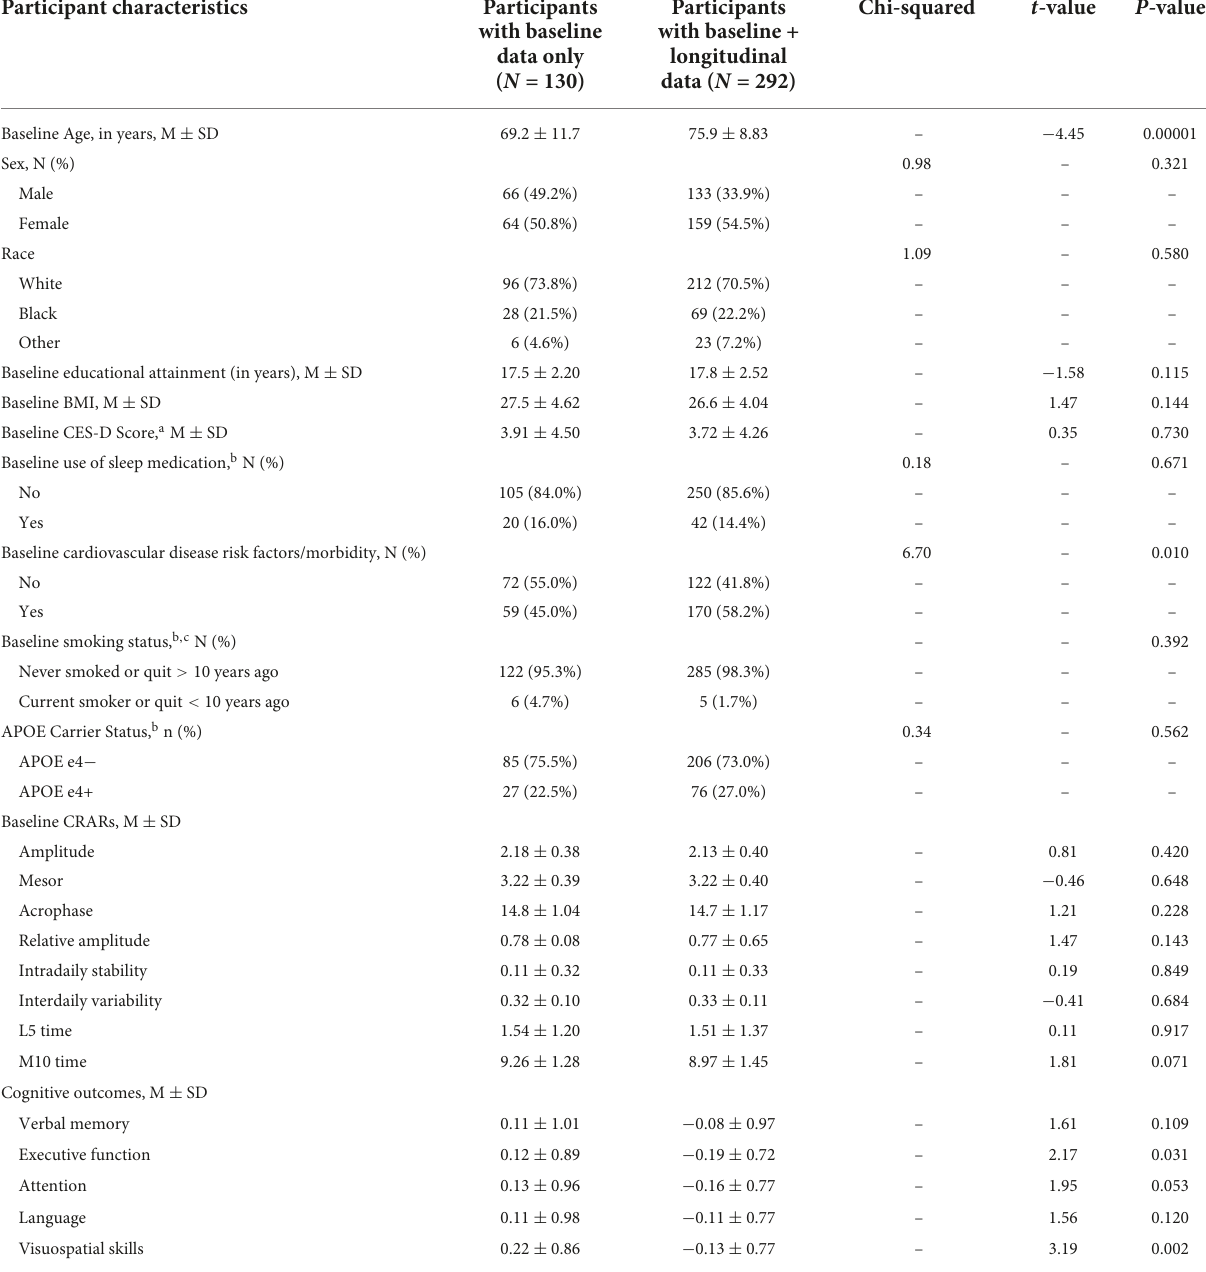
TABLE 5 Descriptive statistics for participants with baseline data only vs. baseline and longitudinal